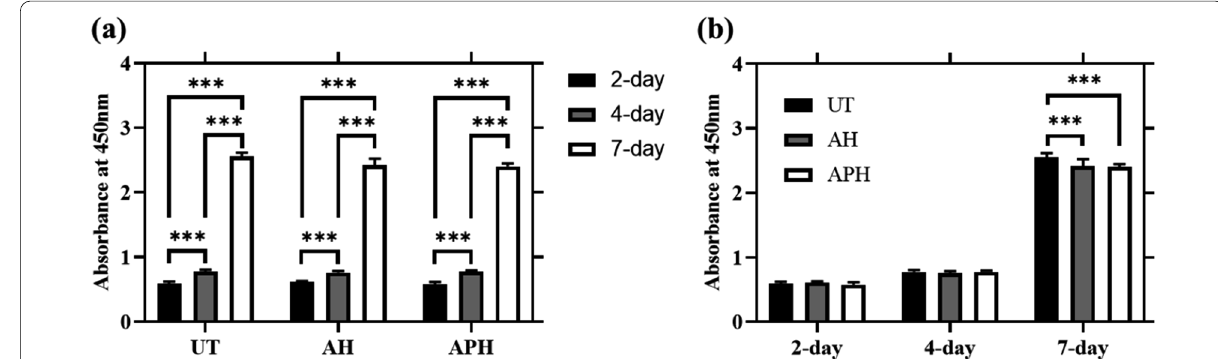
Fig. 5 Cell proliferation behavior was measured by WST‑8 assay after incubating MC3T3‑E1 on specimens for the UT, AH, and APH groups for 1, 4, and 7 days. a Comparison between days, b Comparison between groups. The data were statistically analyzed by two‑way analysis of variance (ANOVA) followed by Tukey’s multiple comparisons test. The results are presented as the means value of < 0.005)